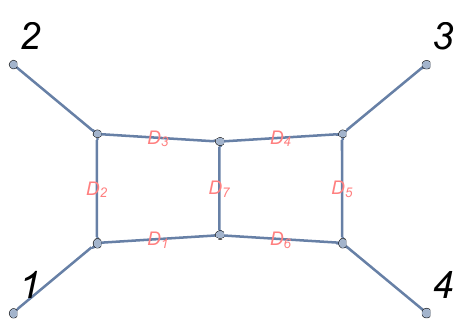
Figure 4 . Massless double box diagram. This graph is produced by the package Azurite